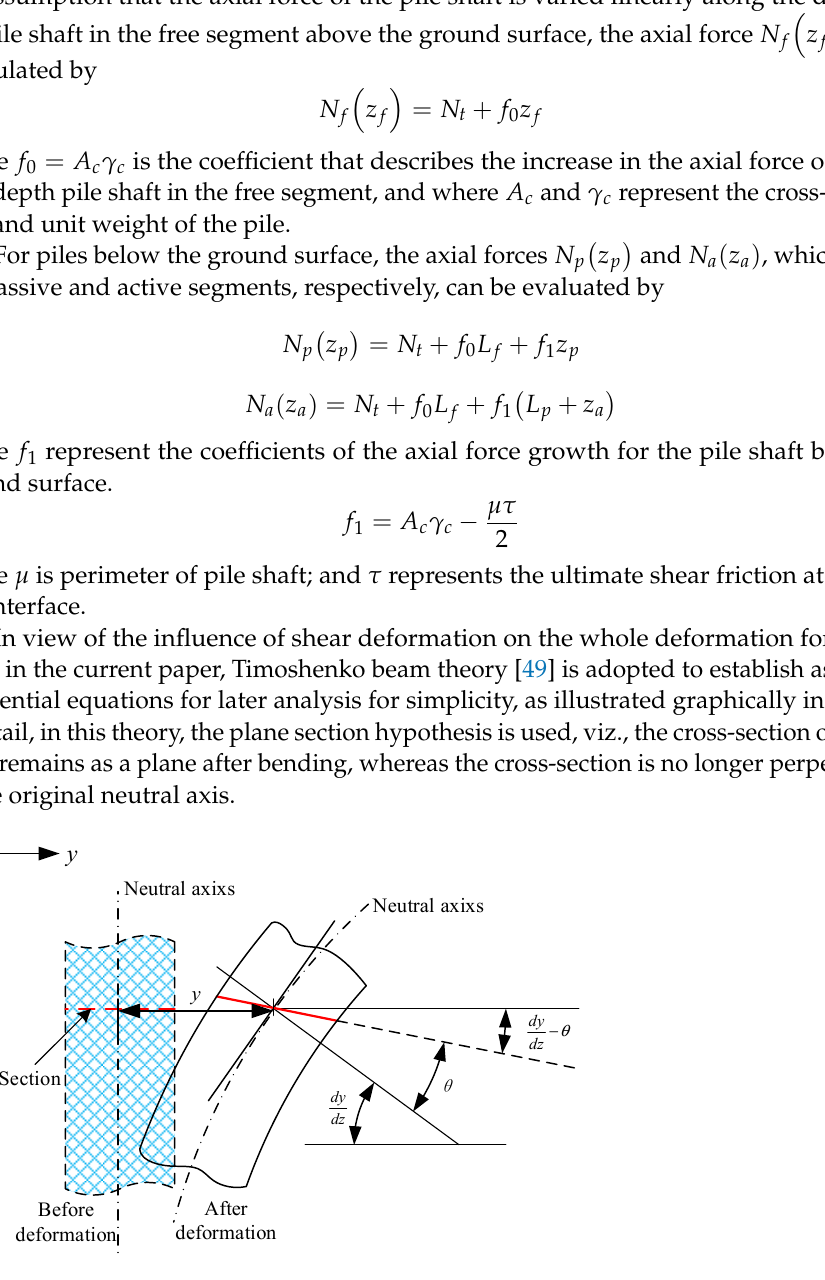
Figure 3. Deformation characteristics of Timoshenko beam.